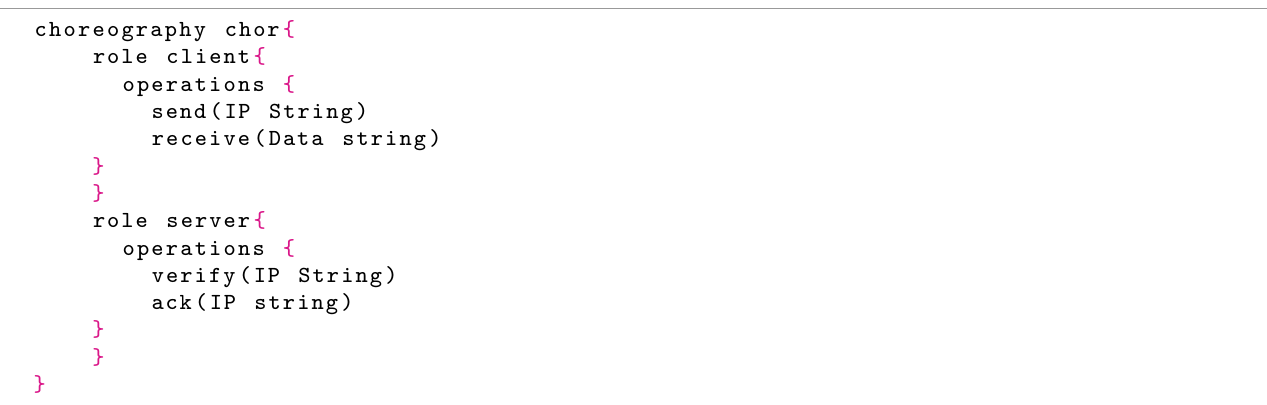
Figure 6. Example of definition of a choreography with 2 roles